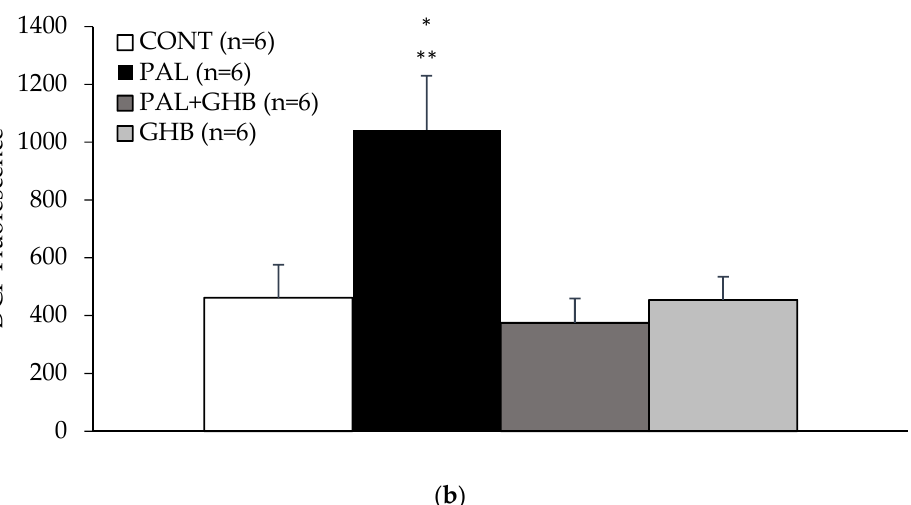
Figure 2. Effects of palmitate and gamma-hydroxybutyric acid (GHB) on ROS levels in mouse islets. ROS levels were determined by H2DCF-DA. Islets were treated for 48 hrs with (1) control media, (2) palmitate (0.4 mM), (3) palmitate (0.4 mM) and GHB (5 mM), and (4) GHB (5 mM) alone. Approximately 10 islets were measured per experiment ( n ). ( a ) Representative images. ( b ) Quantification of results. Palmitate treatment increased ROS while GHB had a protective effect. GHB alone did not affect H2DCF-DA-detected ROS. RFI = relative fluorescence intensity. Data are means ± SE. One-way parametric ANOVA followed by Tukey’s test was performed to compare differences between treatments. * p < 0.05 vs. all, ** p < 0.01 vs. PAL + GHB.